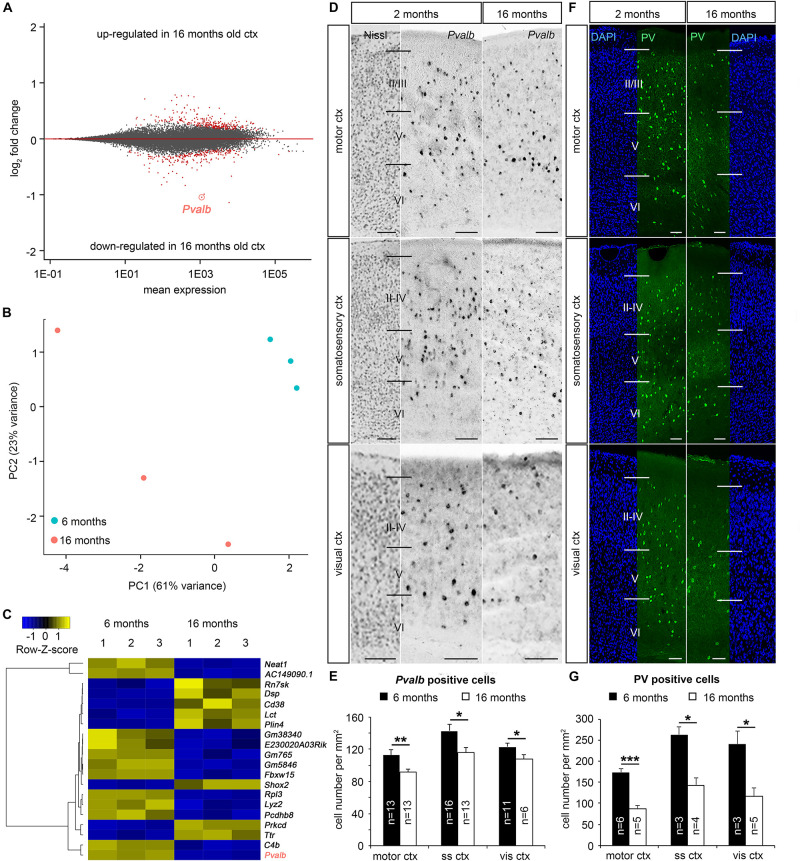
Age-dependent reduction of parvalbumin expression in the mouse cortex. (A) MA-plot illustrating differential gene expression between whole cortical tissue of 6 months (n = 3 brains) and 16 months old (n = 3 brains) C57BL/6 mice. RNA sequencing was performed to reveal age-dependent differential gene expression (red dots, P < 0.05, Benjamini adjusted). (B) Principal component analysis (PCA) illustrates the segregation of the different samples, whereby the first and second PC account for 61 and 23% of the variance, respectively. (C) Heat-map illustrating the 20 genes with highest absolute foldchanges among the differentially expressed genes between cortical tissue samples of 6 and 16 months old C57BL/6 WT mice including Pvalb, which is significantly reduced in aged samples. (D–G)
In situ hybridization and immunohistochemistry against Pvalb mRNA (D) and PV protein (F) in the motor cortex, somatosensory cortex and visual cortex in 6 months and 16 months old C57BL/6 mice (N = 3 different brains per age), quantified in (E) and (G), respectively (*P < 0.05; **P < 0.01; ***P < 0.001, Student’s t-test). Scale bars: 100 μm in (D) and (F).